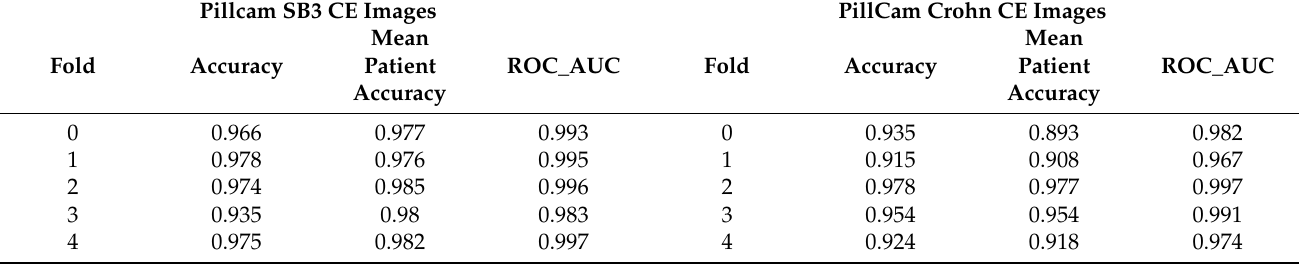
Table 2. Experiment 1-Identification of small bowel ulcerated mucosa according to capsule type.